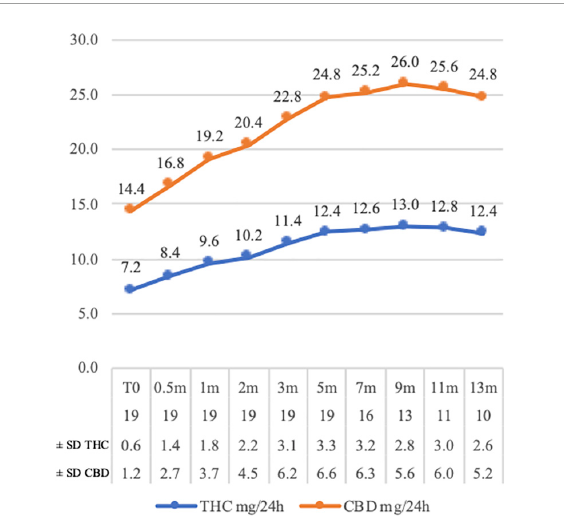
FIGURE1 Tetrahydrocannabinol (THC) and cannabidiol (CBD) mg average daily dosage variations at the time of assessments (CBD dosages are double THC dosages). The number of assessed patients and the dosage standard deviations (THC and CBD) are proposed in the chart legend at each time point. m = month of assessment.